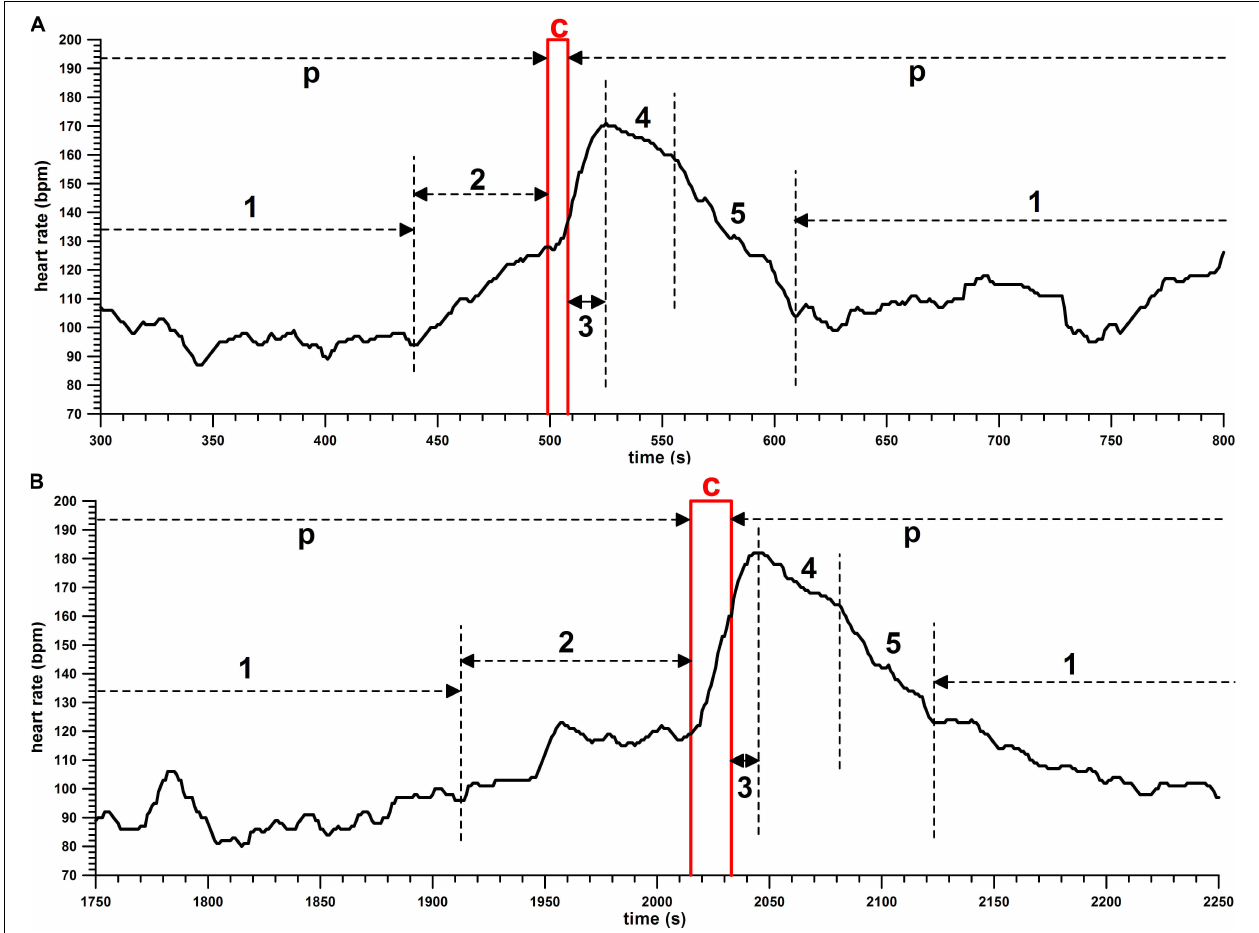
FIGURE 2 | Heart rate (HR; bpm) against time (s), samples of HR profiles of (A) 10-m and (B) 15-m climbs; p, pause; c, climb; 1, rest with low HR; 2, prestart activation immediately before the climb; 3, time to peak HR after the climb; 4, slowly decreasing HR after the peak; 5, fast decreasing